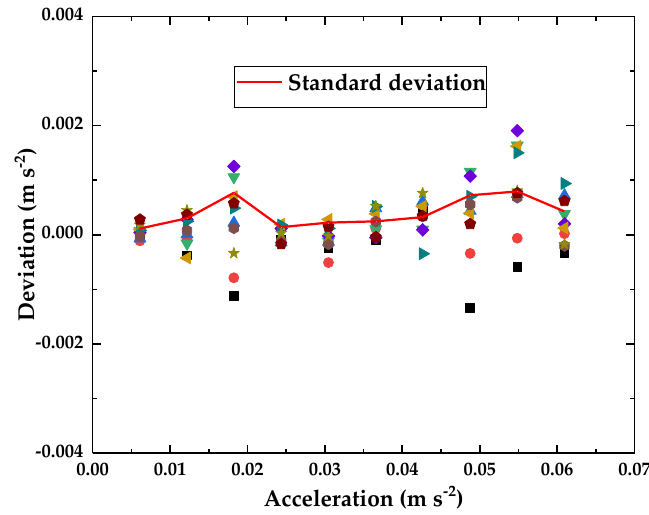
Figure 9. The stability of the optical accelerometer. (The points with same shape and color are the results of the same measurement).